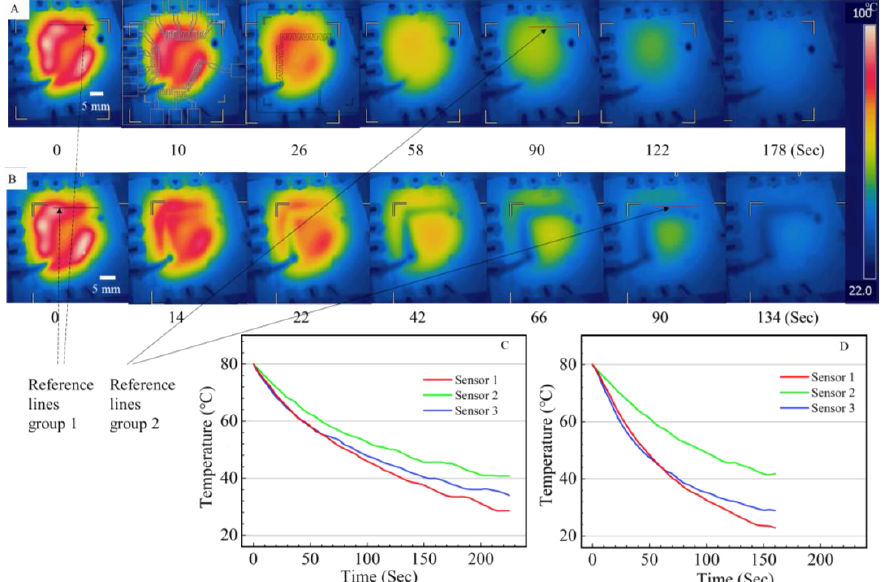
Figure 6. Temperature changes for natural cooling ( A , C ) and positive cooling with room – tempera- ture coolant ( B , D ) recorded by thermal imager ( A , B ) and on – chip temperature sensors ( C , D ). Sensor 1 – top, sensor 2 – bottom, sensor 3 –